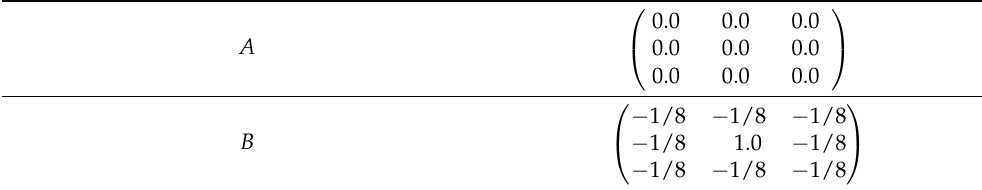
Table 7. Coefficients for the input and output weights in Equation (24) for the case of the edge detection setup.